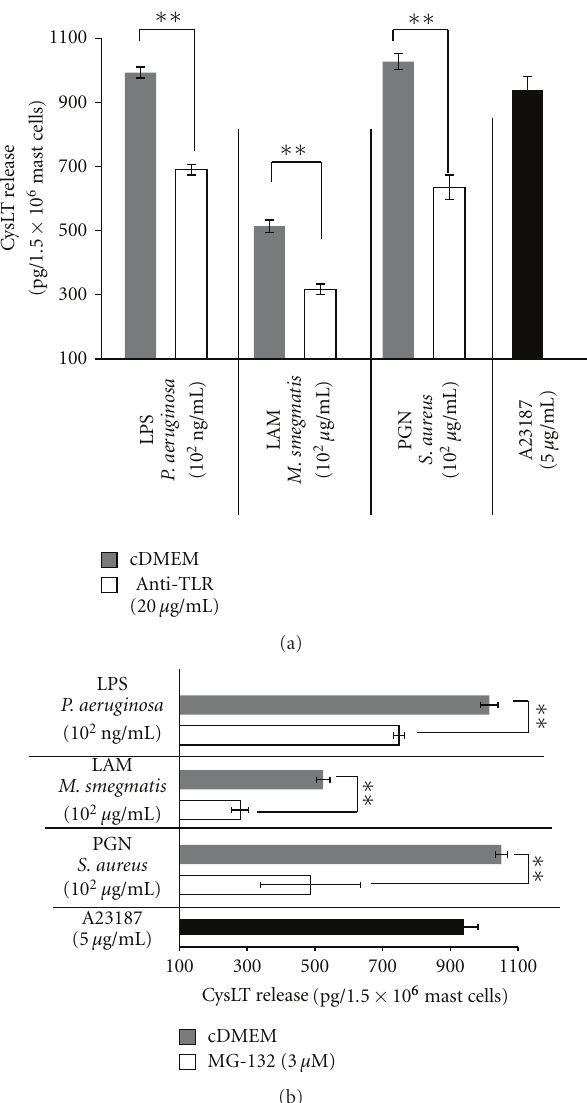
Figure 2: The e ff ect of LPS, LAM and PGN on rat mast cell cysLT synthesis. (a) Mast cells were preincubated with cDMEM (control) or anti-TLR antibodies for 15 min and after washing incubated with LPS, LAM, PGN or bu ff er alone (spontaneous cysLT generation) for 60 min. Results are expressed as the mean ± SEM of three independent experiments and each experiment was done in duplicate ( n = 6). (b) Mast cells were preincubated with cDMEM (control) or MG-132 for 15min and after washing incubated with LPS, LAM, PGN or bu ff er alone (spontaneous cysLT generation) for 60 min. Results are expressed as the mean ± SEM of three independent experiments and each experiment was done in duplicate ( n = 6). ∗∗ P < .